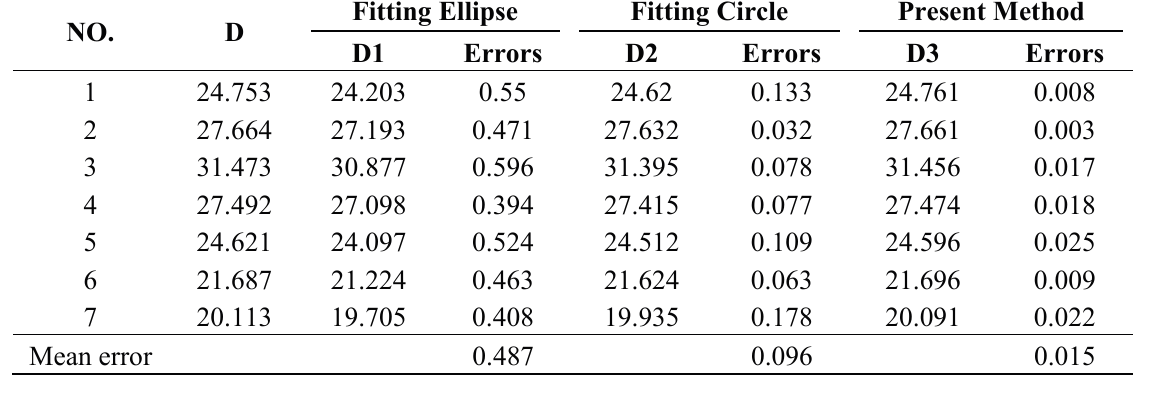
Table 6. Comparison of the measured diameters in shaft 2 (mm).